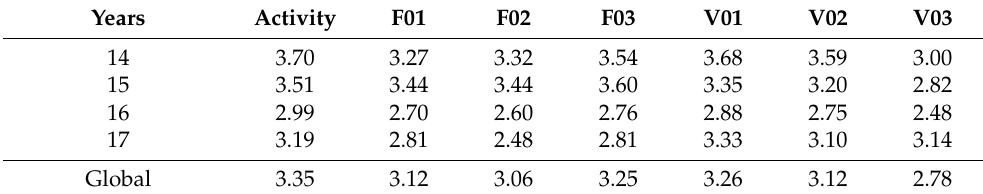
Table 6. Evaluation of the activity and the tests carried out according to